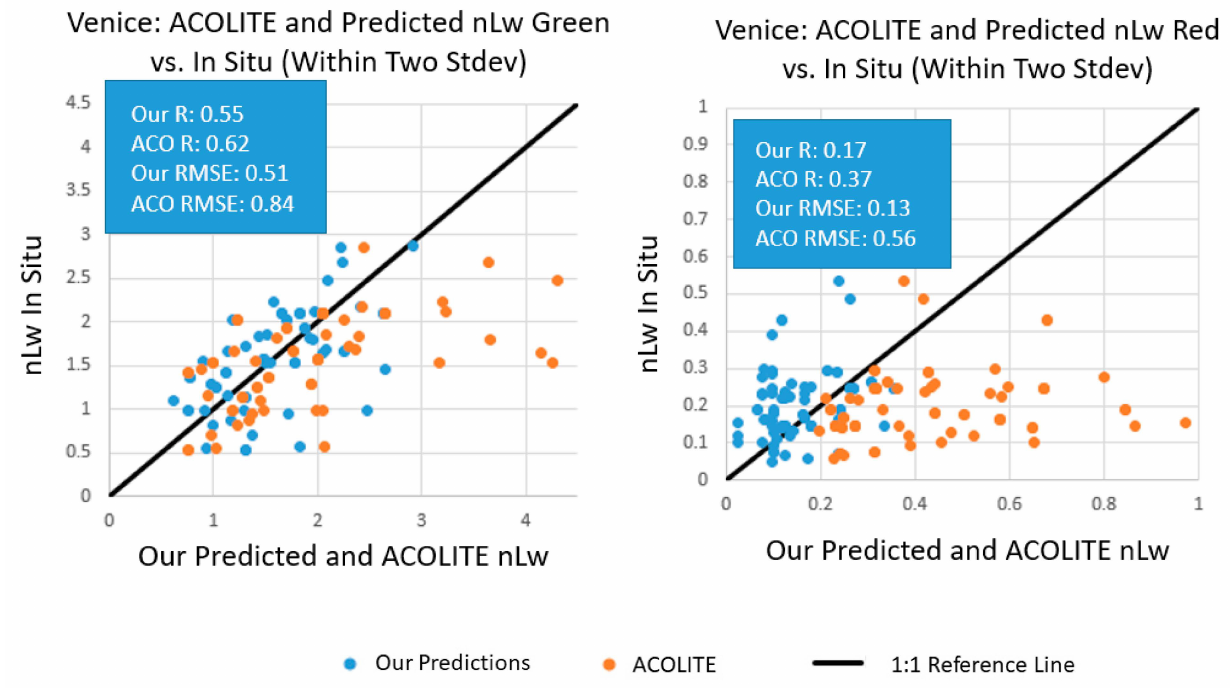
Figure 11. Planet model predicted nLw and ACOLITE nLw compared to MOBY and Venice AERONET-OC in situ nLw. Top left : MOBY blue nLw. Top right : MOBY green nLw. Middle left : MOBY red nLw. Middle right : Venice AERONET-OC blue nLw. Lower left : Venice AERONET- OC green nLw. Lower right : Venice AERONET-OC red nLw.